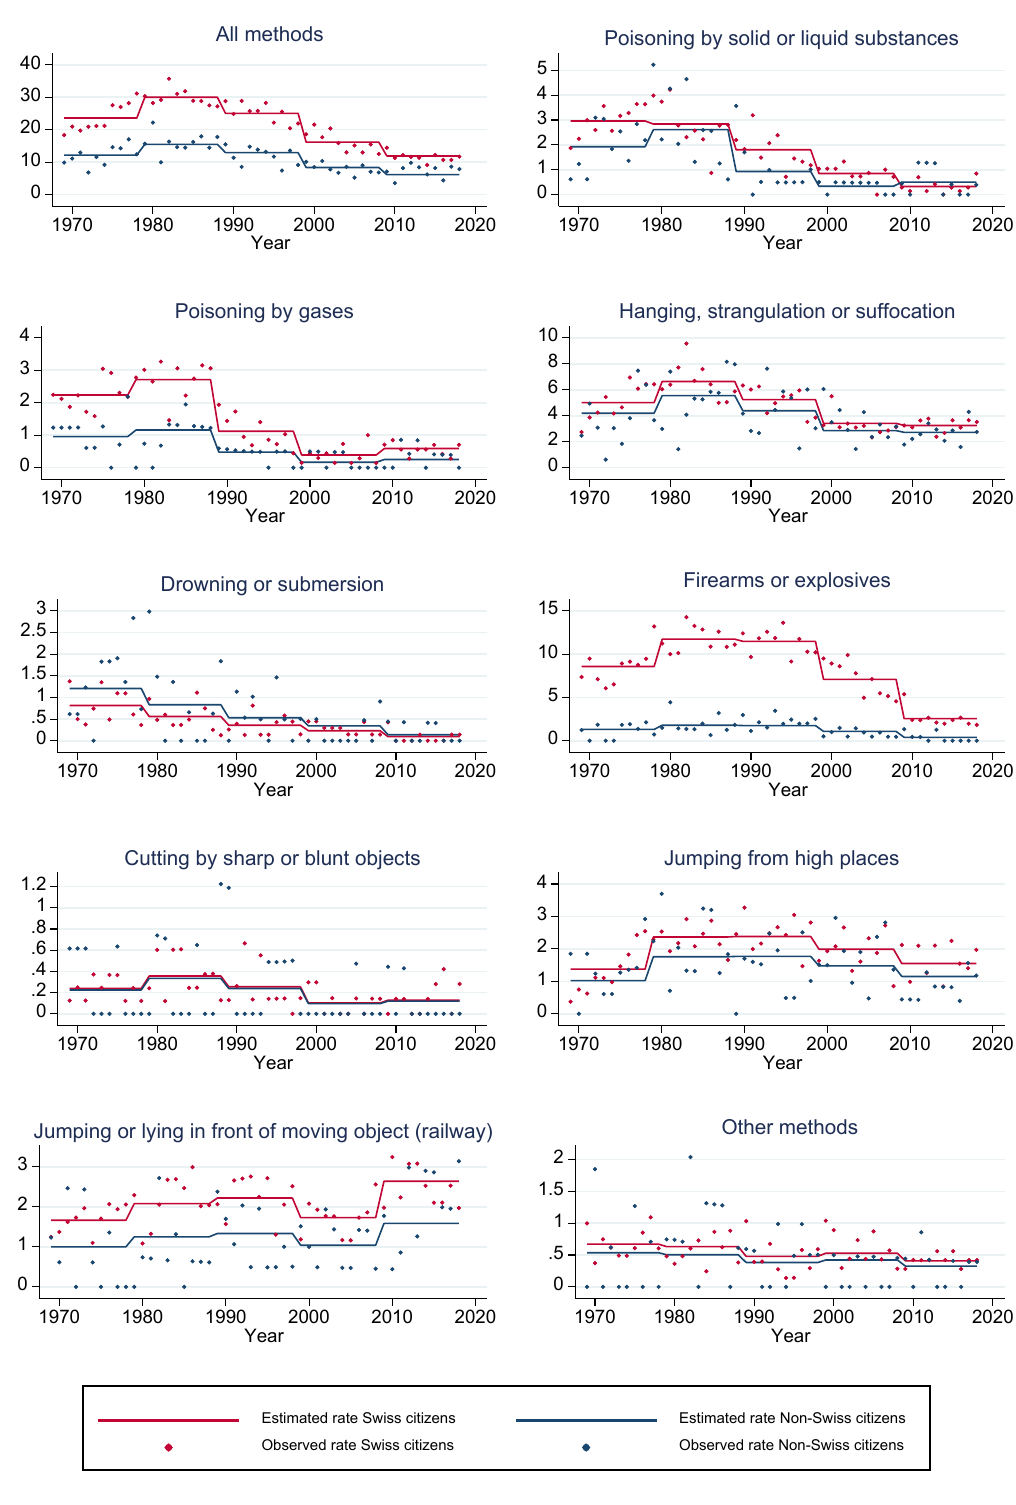
Figure S3. Rates of suicide methods per 100'000 population (person-years) in 10-29 years old